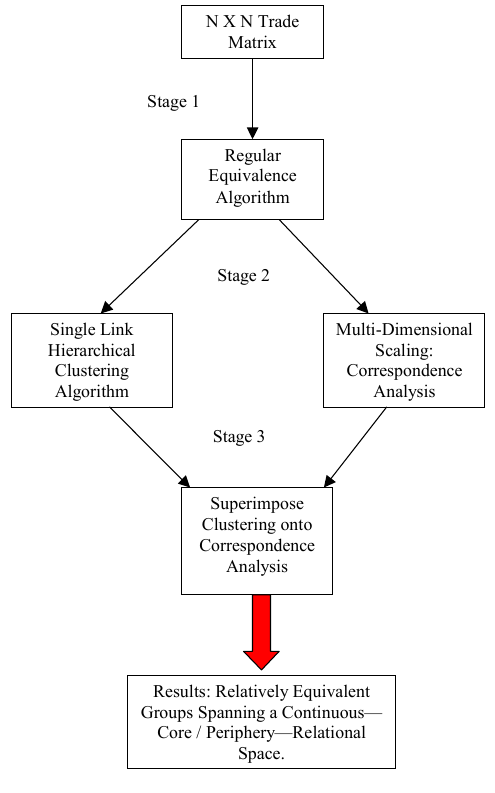
Figure 1: Analytic Strategy for Role and Position